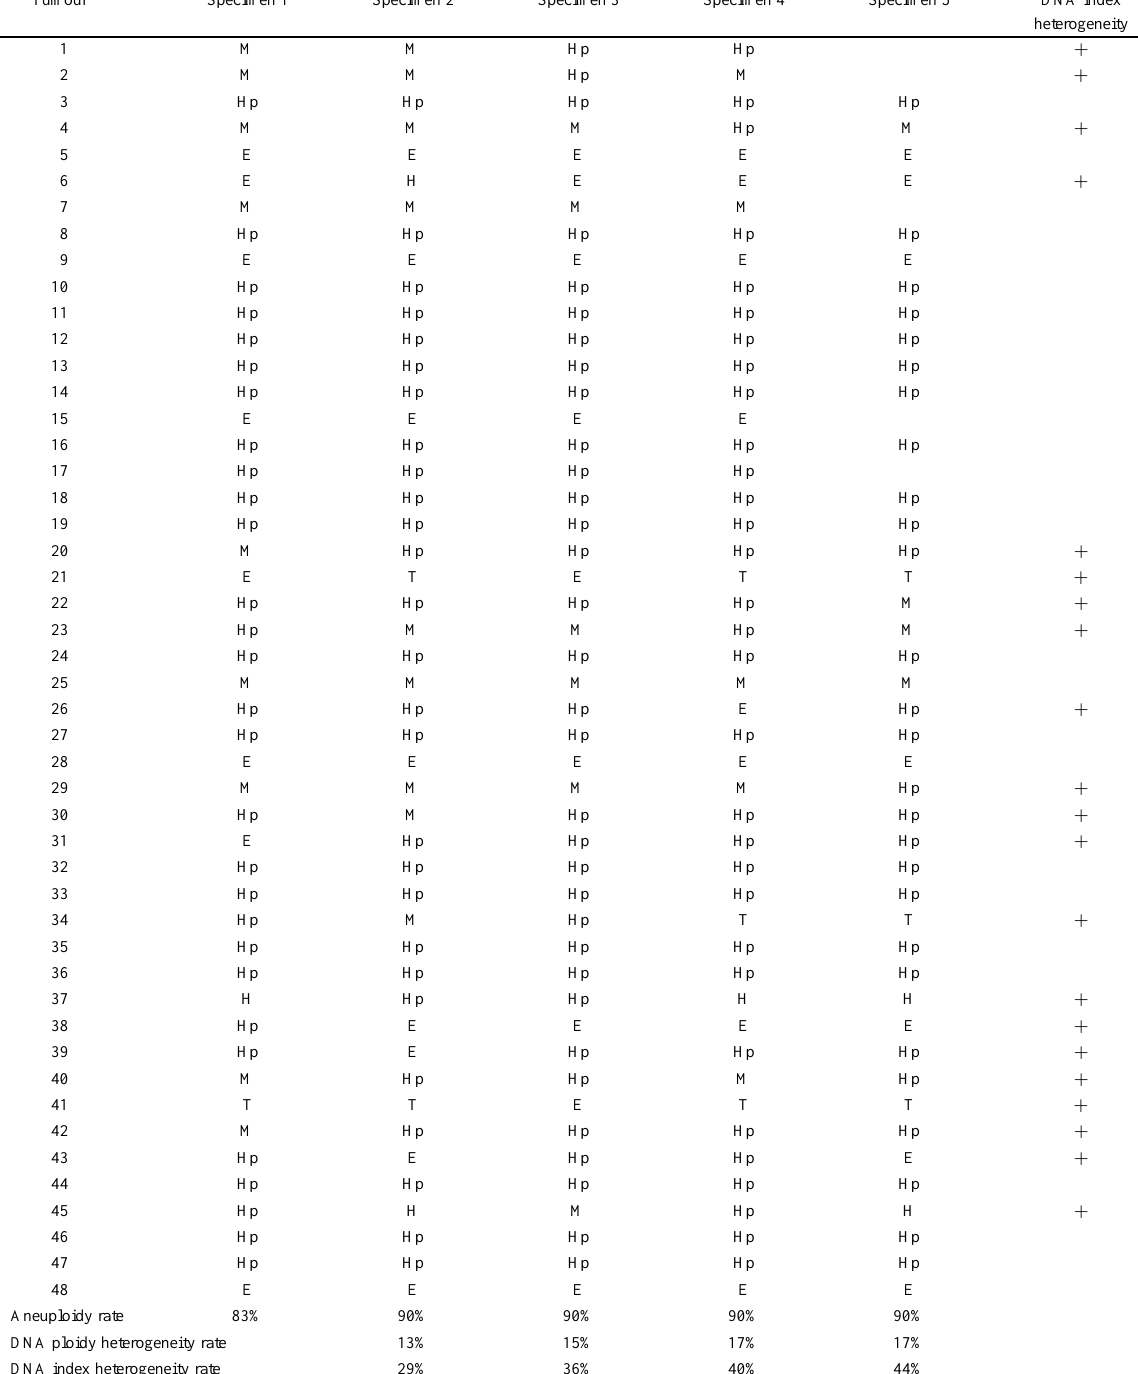
Results of DNA ploidy analysis of all specimens for 48 tumors. (E = euploid, Hp = hyperploid, H = hypoploid, T = tetraploid, M = multiploid) Tumour Specimen 1 Specimen